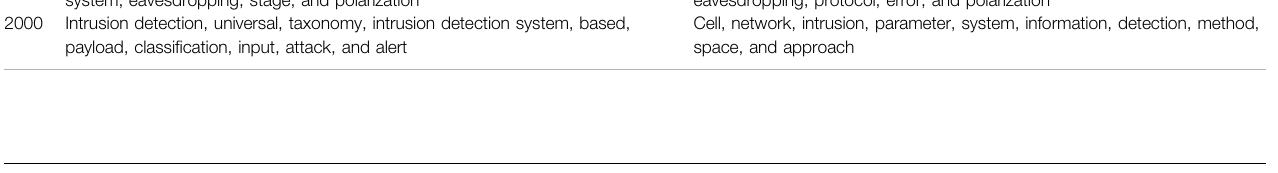
TABLE 4 | Comparing the concept-based, bag-of-words, and automatic phrase extraction methods for a classi fi cation task using three different algorithms on the Cryptography and Security data